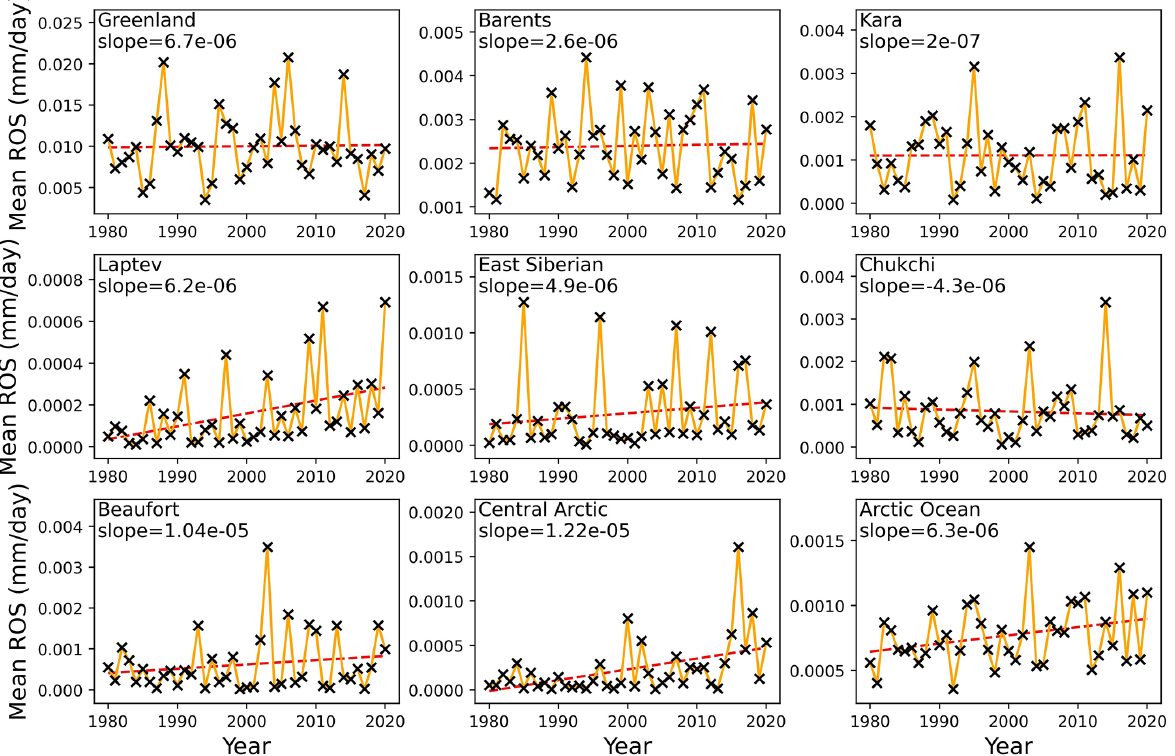
Figure A4. Regionally averaged, time-averaged, non-frozen precipitation (mmd − 1 ) over sea ice in the cold season (October through April).